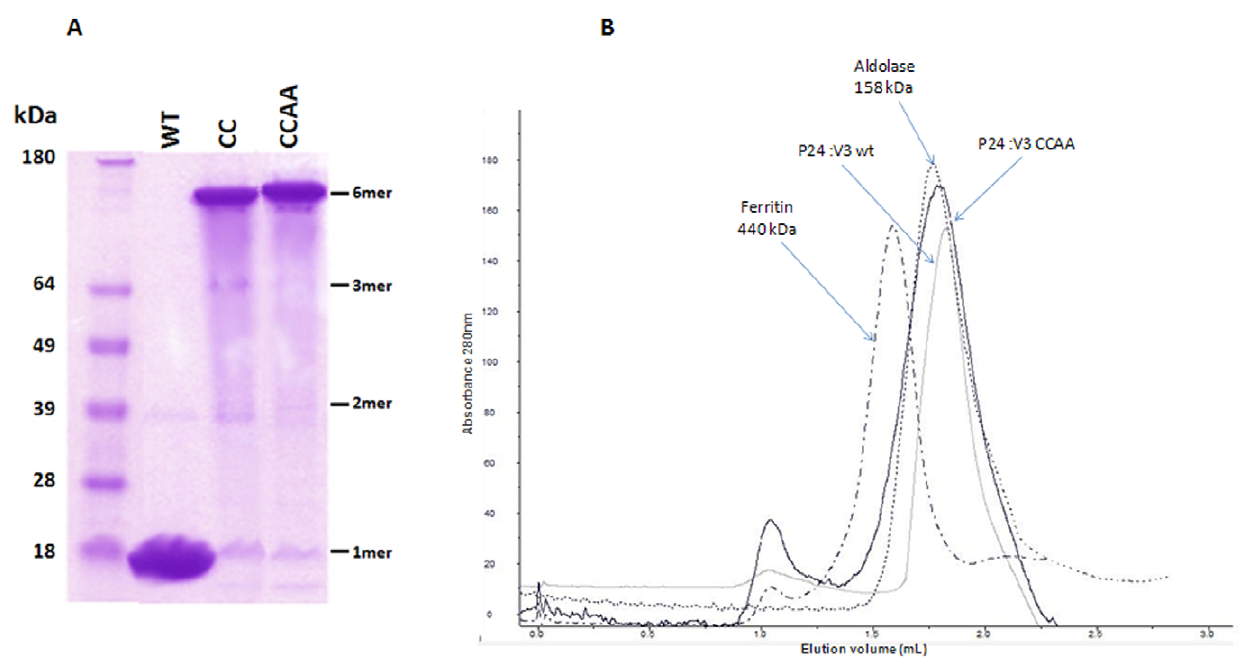
Figure 6. ( A ) Crosslinking of mutant p24:V3 chimera. Proteins were separated in non reducing SDS-PAGE conditions on a 10% polyacrilamide gel. The p24:V3 CC and CCAA mutants migrate almost exclusively as hexamers, while the p24:V3 WT chimera migrates as monomer. ( B ) Size exclusion chromatographic profile. Profile of p24:V3 WT (gray) and p24:V3 CCAA mutant (black) on Superdex-200 PC column is shown. Elution volumes of protein standards such as ferritin (440 kDa,dashed and dotted line) and aldolase (158 kDa, dotted line) are also indicated.